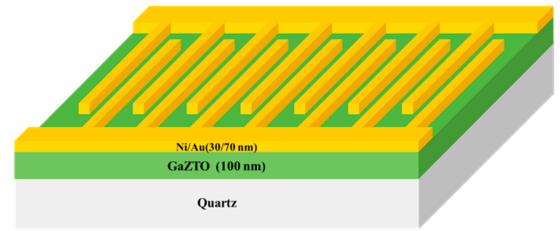
Figure 1. Structural diagram of the GaZTO solar-blind